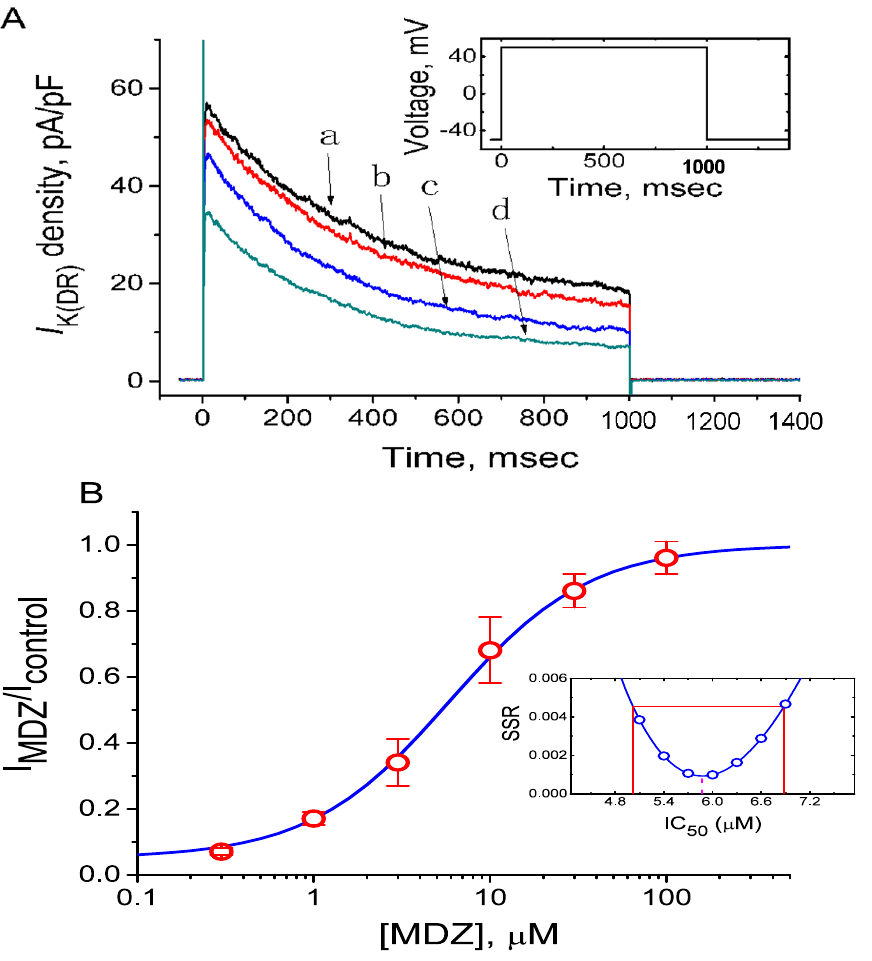
Figure 3. Concentration–response relationship for MDZ-induced inhibition of I K(DR) density in Jurkat T-lymphocytes. ( A ) Original current densities of I K(DR) obtained with or without addition of MDZ. a: control; b: 3 μ M MDZ; c: 10 μ M MDZ; d: 30 μ M MDZ. Inset in ( A ) indicates the voltage protocol used. ( B ) Concentration–response curve for MDZ-induced inhibition of I K(DR) density in Jurkat T-lymphocytes. The I K(DR) density measured at the end of depolarizing pulses during cell exposure to MDZ was compared with the control value (mean ± SEM, n = 8–13 for each point). The blue smooth line represents a best fit to a Hill function described in Materials and Methods (Equation (1)). The values for IC 50 , maximally inhibited percentage of I K(DR) density, and the Hill coefficient were 5.87 µ M, 95% (A = 0.95), and 1.1, respectively. Inset in ( B ) shows confidence assessment of best-fit parameter values (i.e., IC 50 ). The parameter range corresponds to the approximate 90% confidence intervals. Red line marks the parameter value at which SSR (the sum of squared residuals) amounts to